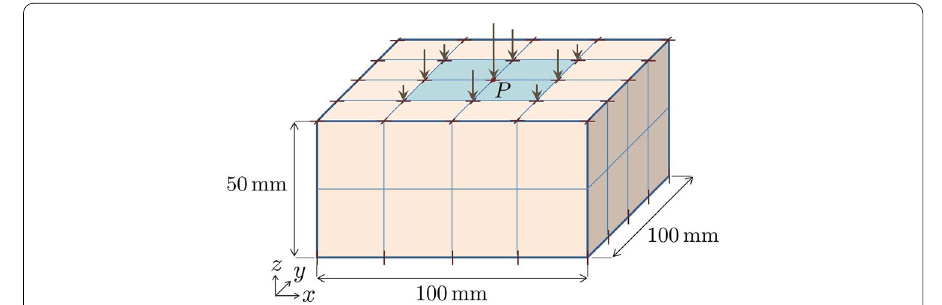
Fig. 10 3D block, geometry, boundary conditions, loading and discretization